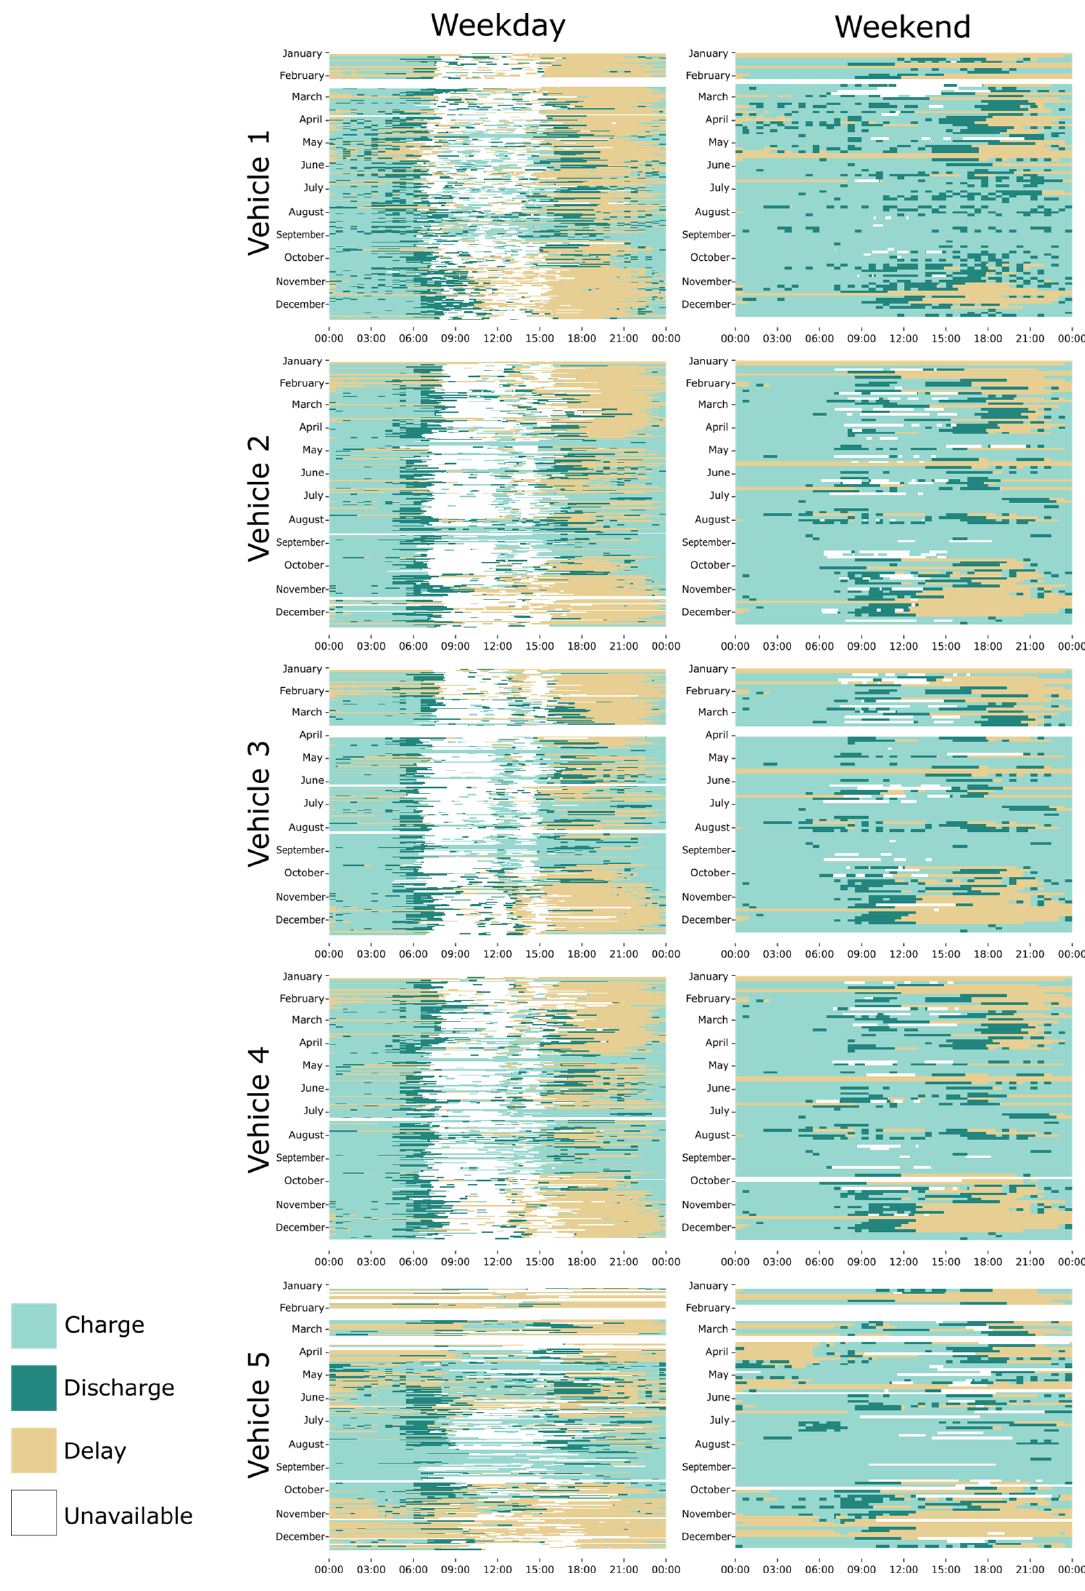
Figure 11. Simulation result of charging and discharging sessions based on the proposed V2G charging scheme, prioritising environmental benefits.